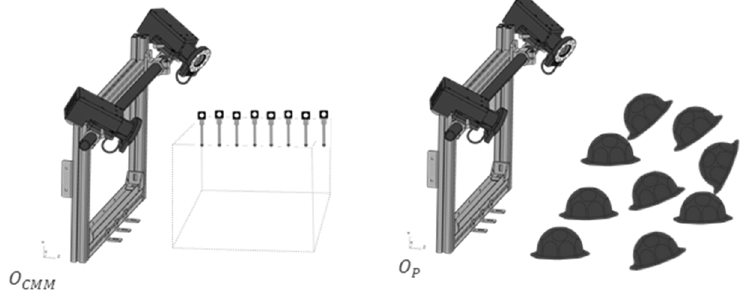
Figure 9. Virtual cube grid ( left ). A single retroreflective target is captured in different images from different points of view. Portable photogrammetry system ( right ). A 3D geometry pattern is resolved by a portable photogrammetry system.